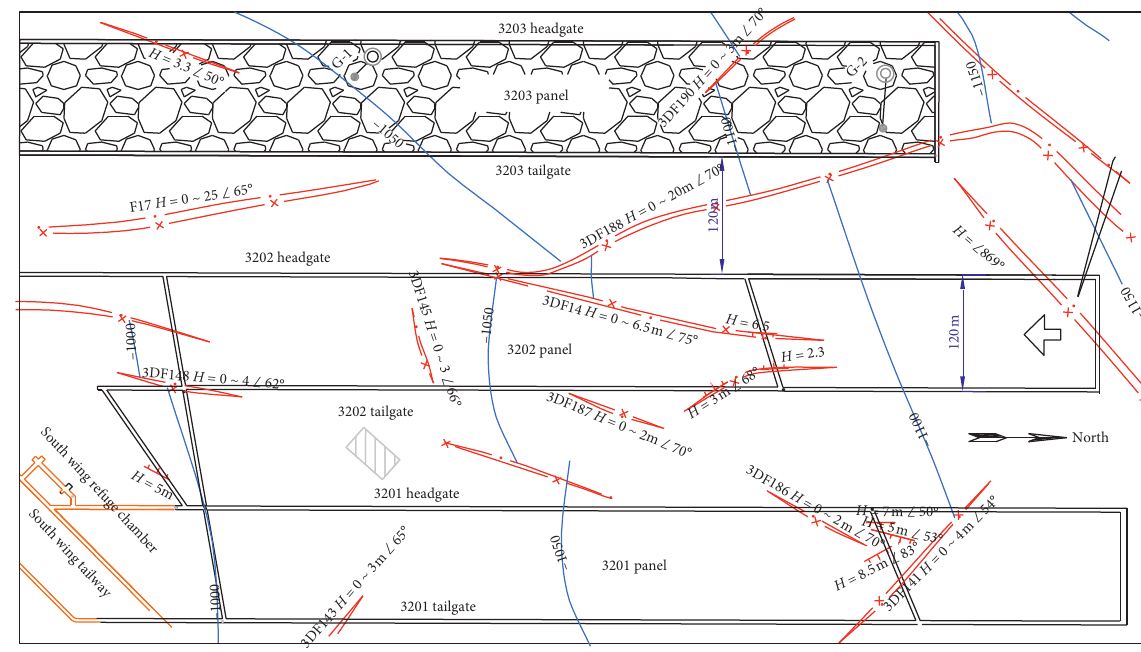
Figure 2: Layout of the 3202 panel.